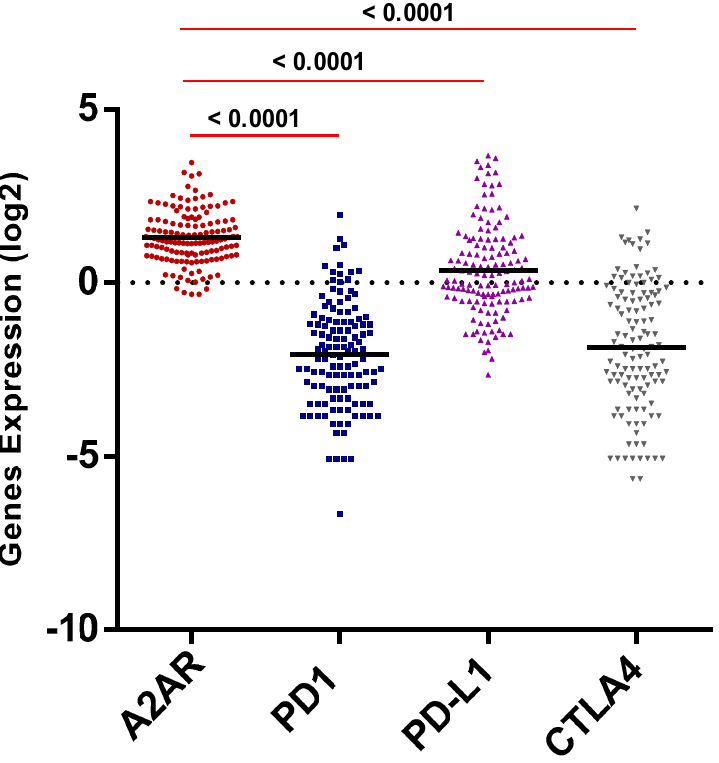
Figure 4. A 2A R expression level was higher than PD1, PD-L1, and CTLA4.